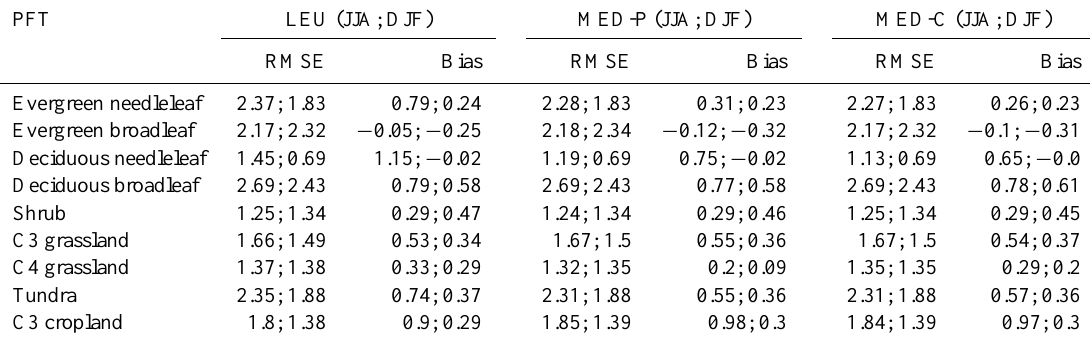
Table 9. Summary statistics for December-January-February (DJF) June-July-August (JJA), describing the root mean squared error (RMSE) and bias taking the GLEAM ET product as